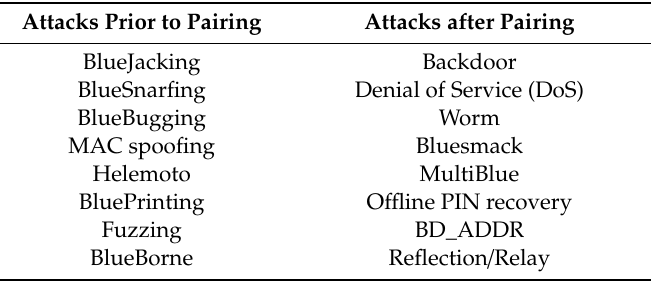
Table 3. List of Bluetooth